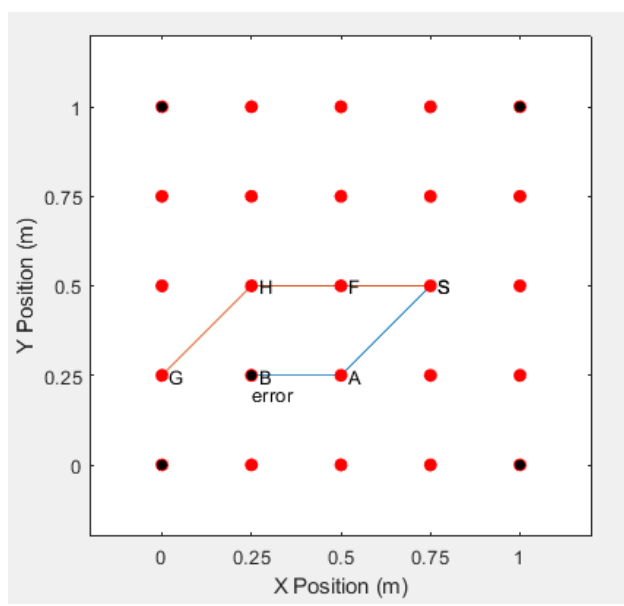
Figure 12. Simulation Without Self-healing